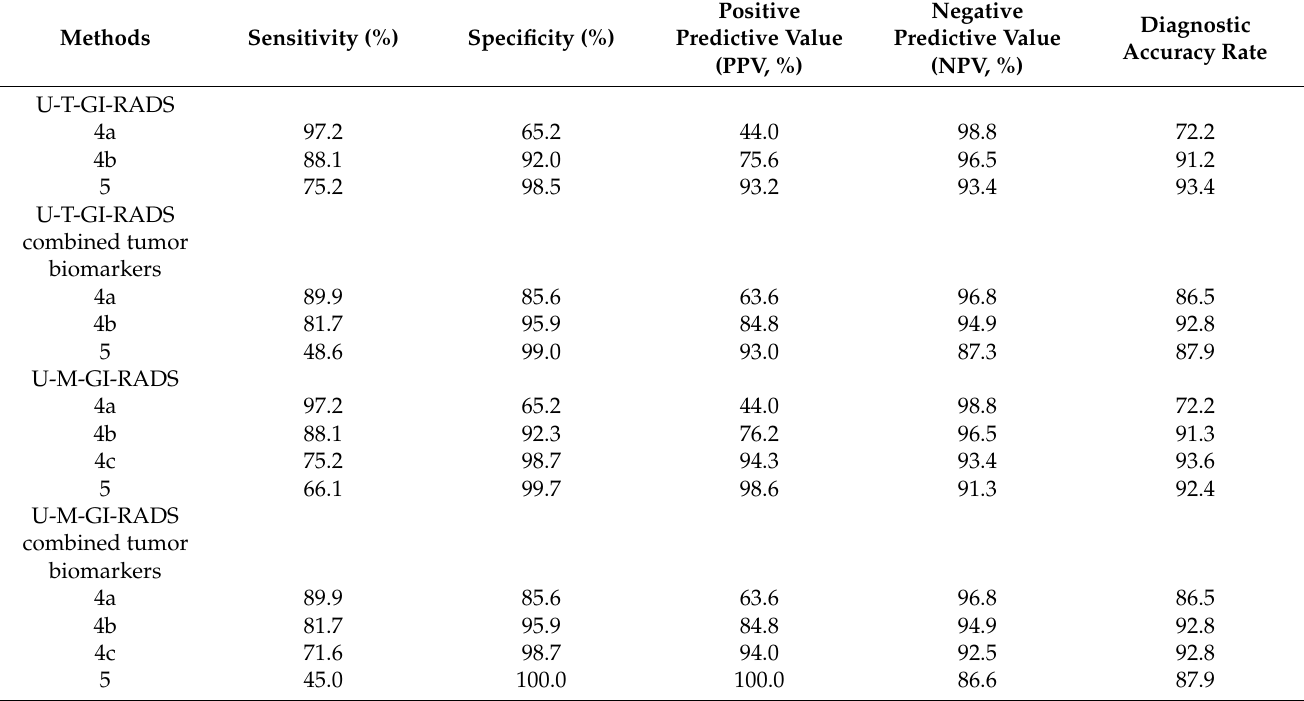
Table 6. The evaluation of the diagnostic efficacy of the traditional and modified GI-RADS grading system in differentiating benign and malignant uterine cavity and endometrial